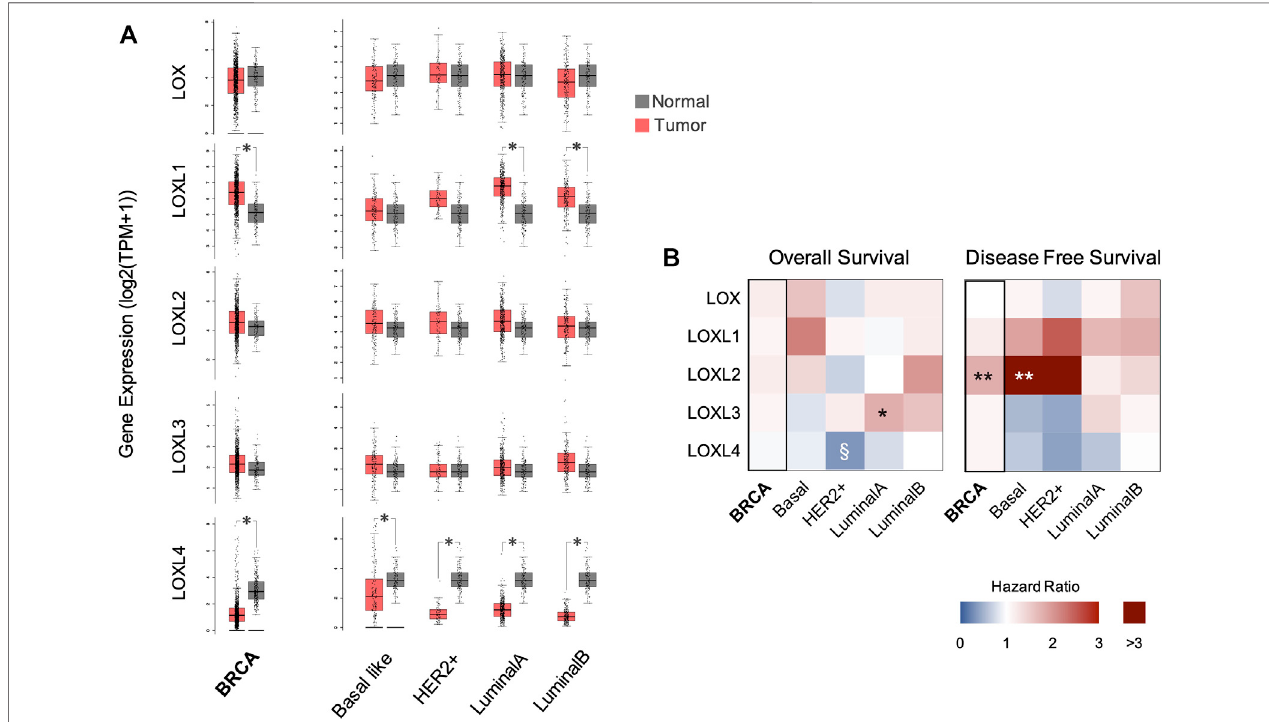
FIGURE1| LOX familygeneexpressionandbreastcancerpatientsurvival. (A) LOX smRNAexpressionpro fi lingcomparativeanalysisbetweenBRCA( n =1085)or itssubtypes(Basal-like n =135;HER2+ n =66;LumA n =415;andLumB n =194)andnormal( n =112)tissuesamples.* p < 0.01(one-wayANOVA). (B) Overallsurvival and Disease-free survival Hazard ratio in patients with high tumour levels of LOX s mRNA calculated from Kaplain-Meier curves using the Cox PH Model. Hazard ratios using LOX s expression median were calculated for BRCA and its subtypes. * p < 0.05, ** p < 0.01, § p = 0.051 (Logrank test).